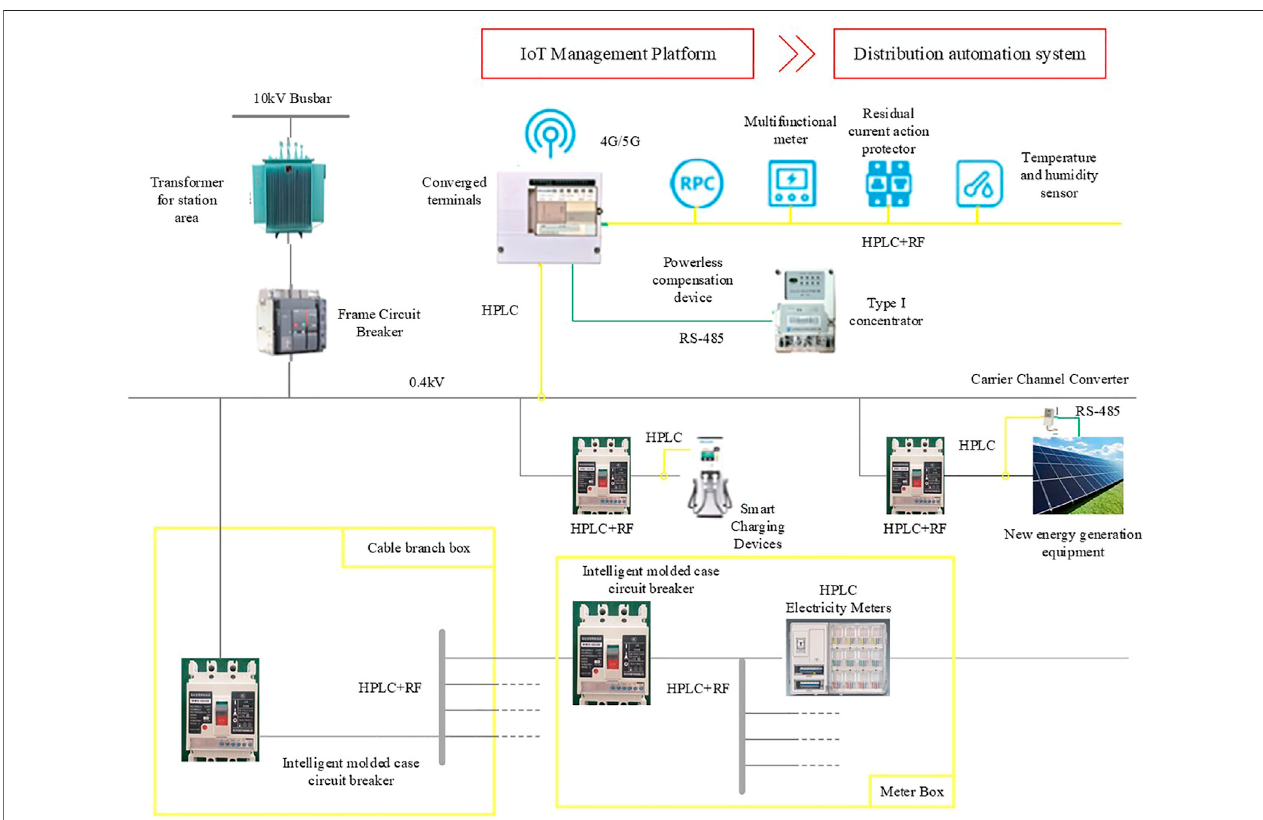
FIGURE 5 | Optimized low-voltage station